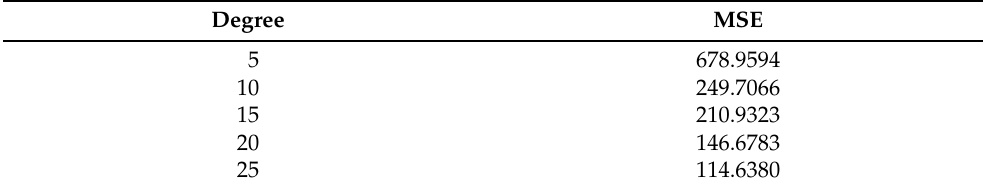
Table 3. MSE for the ANN-based approach for polynomials with real and complex roots in polar